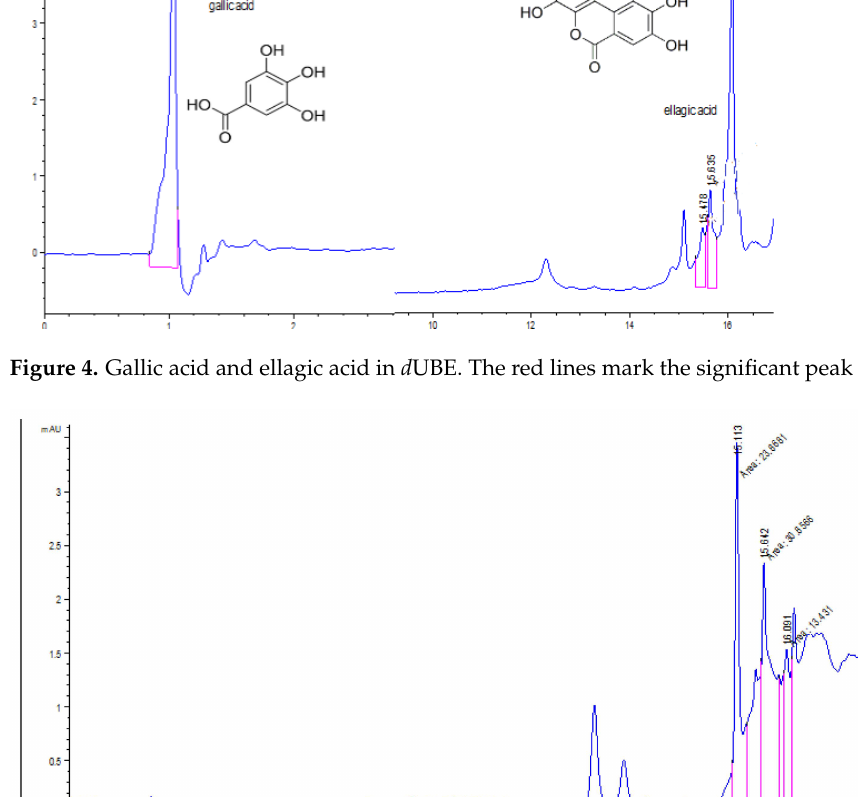
Figure 5. Chromatogram of d UBW. The red lines mark the significant peak areas.